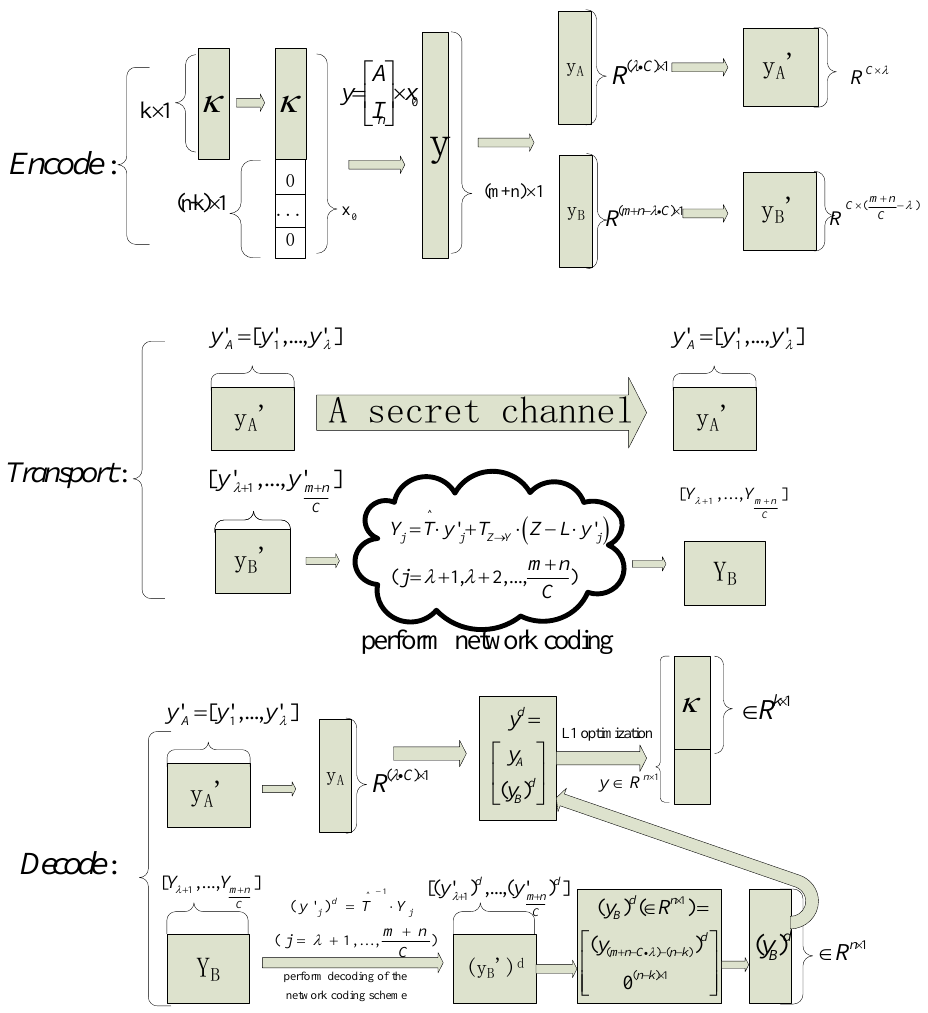
Figure 2. The diagrammatic sketch about Algorithm 1. The squares with white represent those added 323 zeros in the end of packets. Other graphic elements represent ordinary cases.